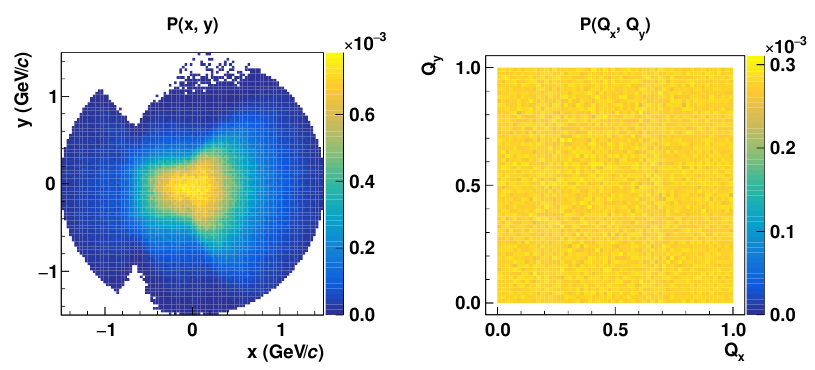
Figure 2. Example of the effect of the cumulative transformation of transverse momentum compo- nents, p x and p y (denoted as x and y ), selected for proton intermittency analysis of the NA61/SHINE 40 Ar + 45 Sc at 150 A GeV/ c data. Distribution before ( left ) and after ( right ) the cumulative transforma- tion are